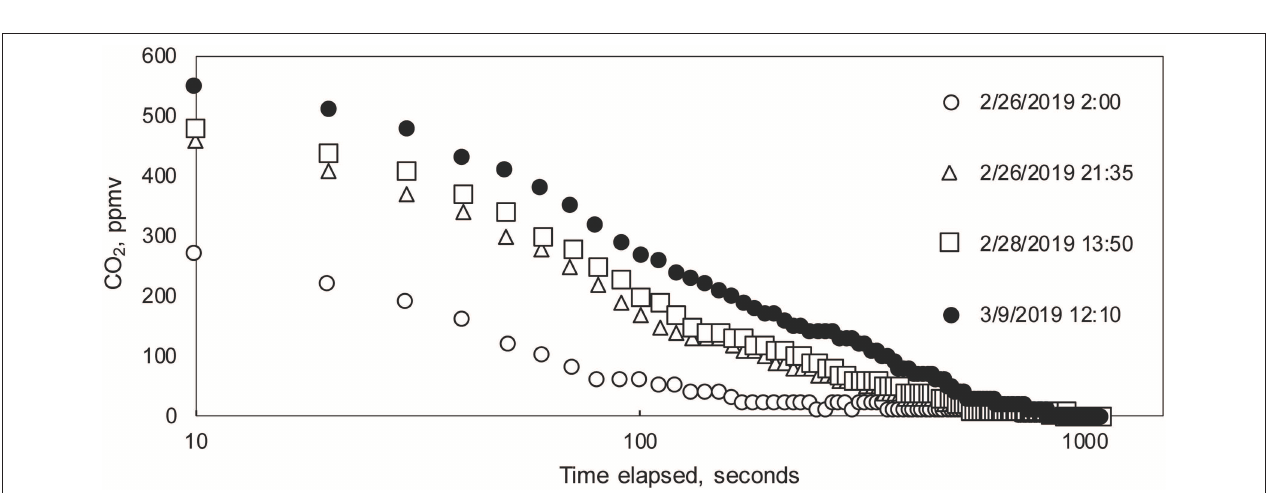
FIGURE 5 | (A–D) Post-processing steps for PCO 2(stream) data. (A) Example of full measurement cycle data, which includes initial peak in first 100s. (B) Example of initial filtering removing first 100s of measurement cycles for nine measurement cycles on 26 February. (C) The last measurement value during each measurement cycle was selected as the “stabilized” value for comparison with the interpolated Vaisala data. The measurement cycle data comprise the gray-shaded area in (B) . (D) Example of filtered from data set in (B) .